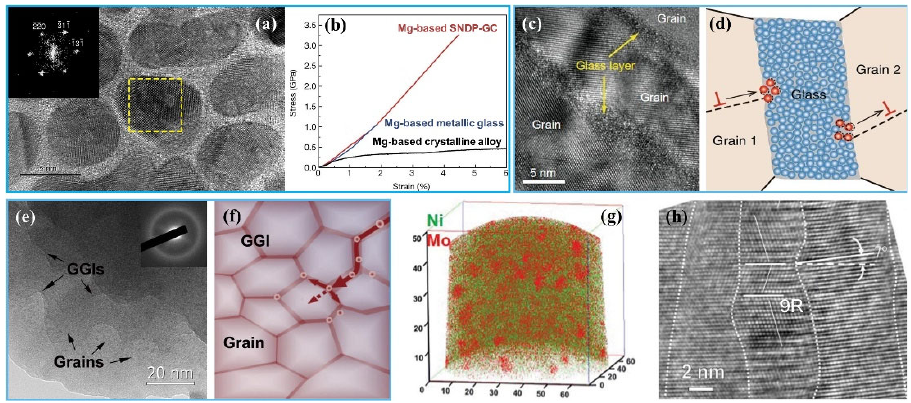
Figure 12. ( a ) HRTEM image of the Mg ‐ based SNDP nanostructure, and the inset is the fast Fourier transform (FFT) image of the MgCu 2 nanocrystal marked by the dashed line [29]; ( b ) engineering stress–strain curves for micropillar Mg ‐ based SNDP glass crystal, a Mg ‐ based metallic glass, and a Mg ‐ based crystalline alloy [29]; ( c ) HRTEM image of nanostructured Al 95 Ni 2 Y 3 alloy [30]; ( d ) schematic of dislocation activities [30]; ( e ) HRTEM image of the Sc–Fe supra ‐ nano ‐ glass, the inset is the SAED pattern recorded from the region shown in ( e ) [176]; ( f ) schematic of the GGIs in the supra ‐ nano ‐ glass (the arrows refer to the growth directions of embryonic shear band and the symbols represent the shear transformation zone) [176]; ( g ) APT image showing distributions of Ni and Mo in the Ni–Mo alloy sample [173]; ( h ) HRTEM image of the Al–Fe alloy showing high ‐ density 9R phase, coherent TBs, and SFs [177].